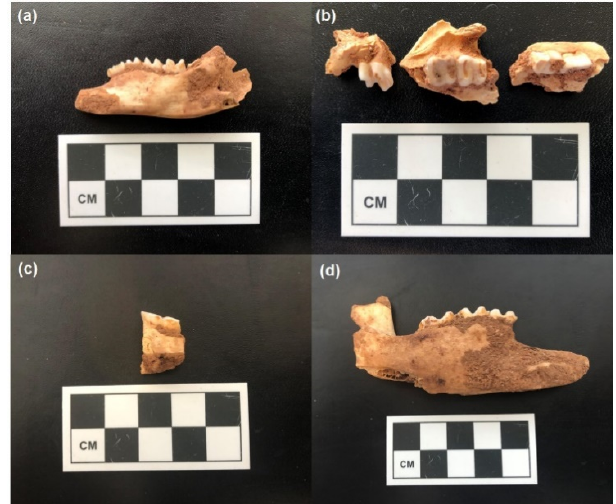
Figure 4. Examples of archaeological macropod teeth used for isotopic analysis from Boodie Cave: ( a ) right mandible fragment of O. robustus containing P3, M1, M2, M3 (from square G100, strati- graphic unit 3, excavation unit 510); ( b ) left maxilla fragments of O. robustus containing P3, M1, M2, M3 and M4 (from square G101, stratigraphic unit 3, excavation unit 534); ( c ) left mandible fragment of L. conspicillatus containing M2 and M3 (from square G101, stratigraphic unit 3, excavation unit 534); ( d ) left mandible fragment of L. conspicillatus containing M2, M3, and M4 (from square F101, stratigraphic unit 3, excavation unit 409).